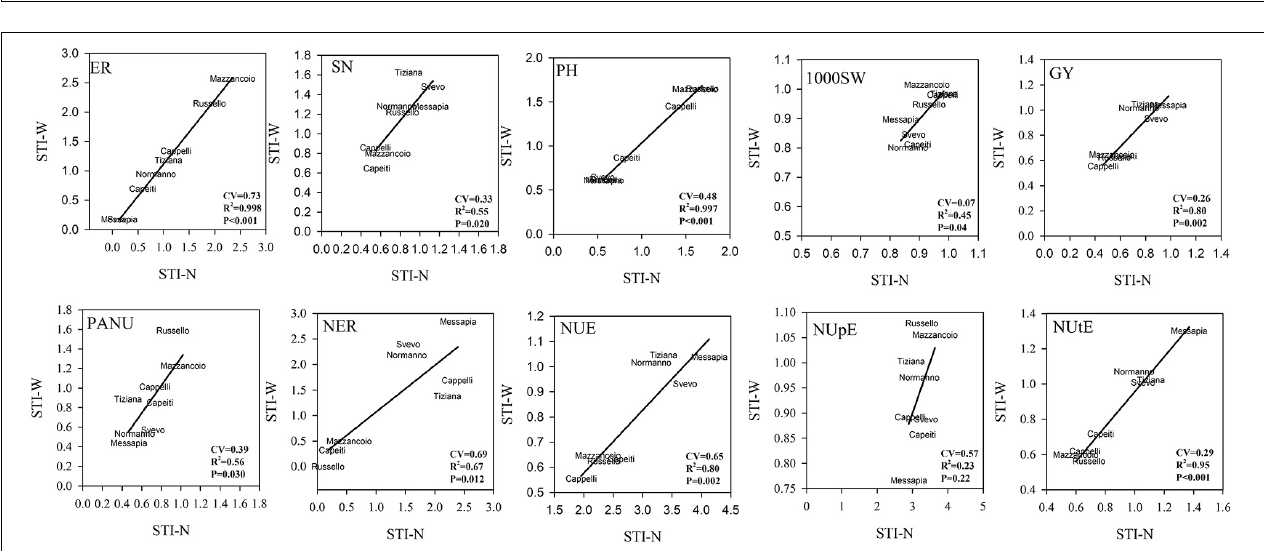
FIGURE 4 | Biplot of stress tolerance index (STI) for N and water stress for each trait. Pearson’s correlation was calculated, and R 2 as well as their significance are reported. Coefficient of variation was also reported (for STI calculation, see section “Materials and Methods”).